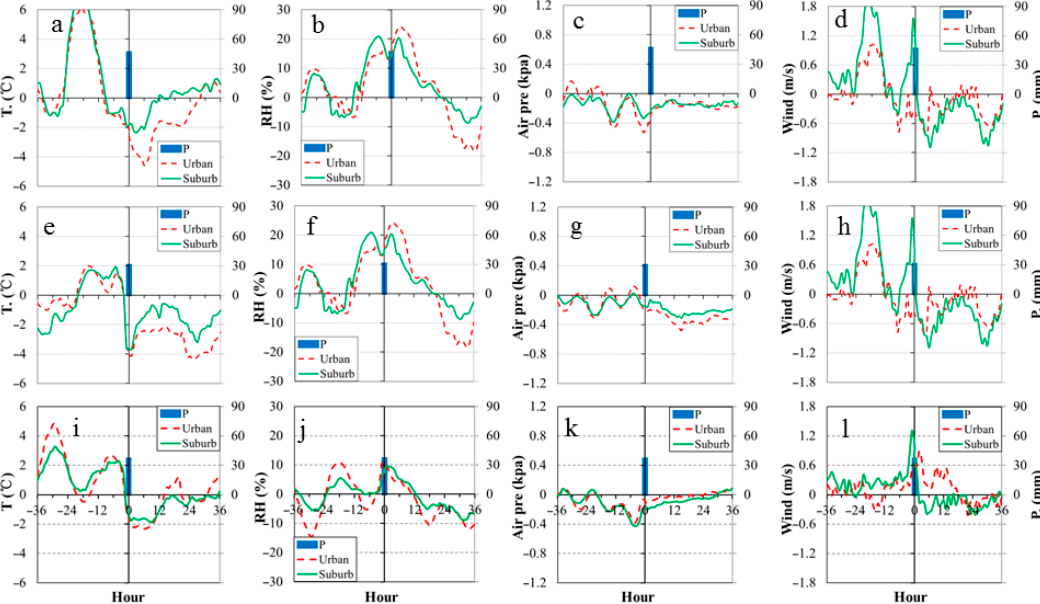
Figure 7. Anomalies of air temperature, relative humidity, surface pressure, and wind speed 36 h prior to, and after the cold-front storms that occurred in the morning (8:00–12:00; a – d ), afternoon (13:00–18:00; e – h ), and night (19:00–7:00; i – l ). The references are the diurnal mean during a two-week period centered at but excluded from the 72 h of storm period from July 2015 to October 2017. The precipitation in the right-hand axis is the mean event-total rainfall.